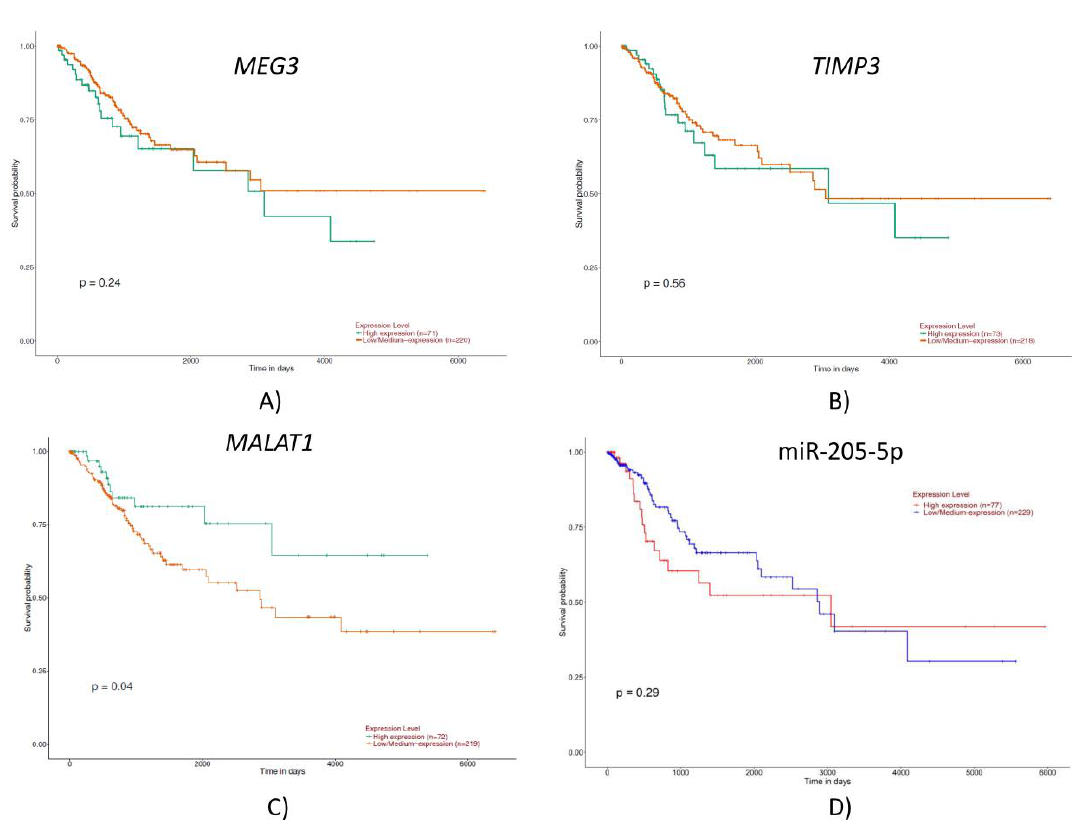
Figure 3. Survival curves for ( A ) MEG3 , ( B ) TIMP3 , ( C ) MALAT1 and ( D ) miR-205-5p .